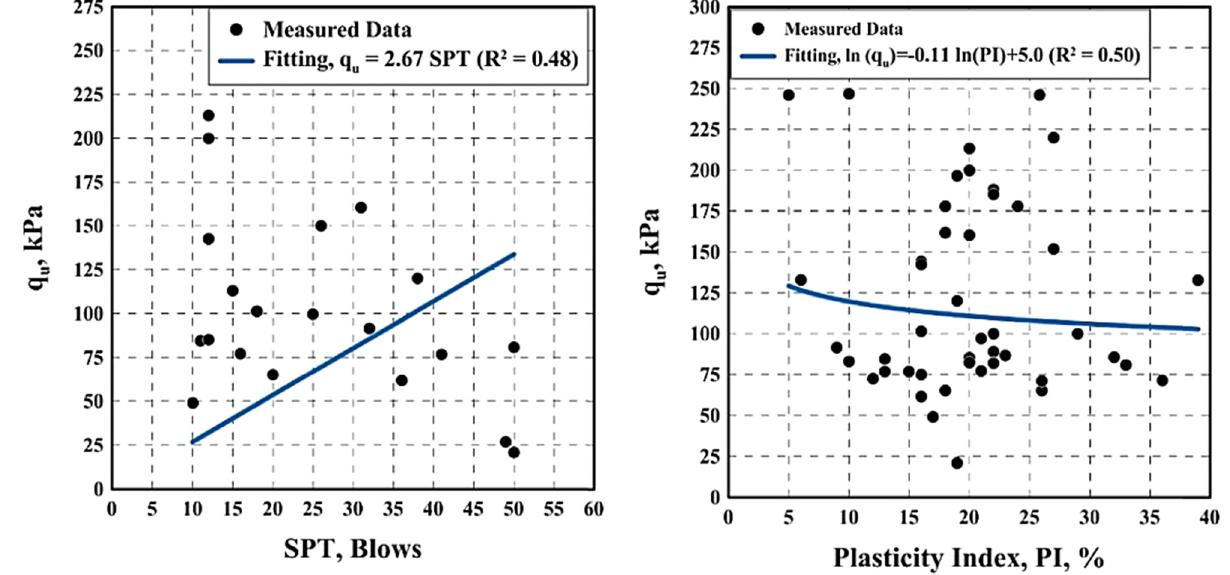
Figure 16: Uncon fi ned compressive strength versus PI relationship.